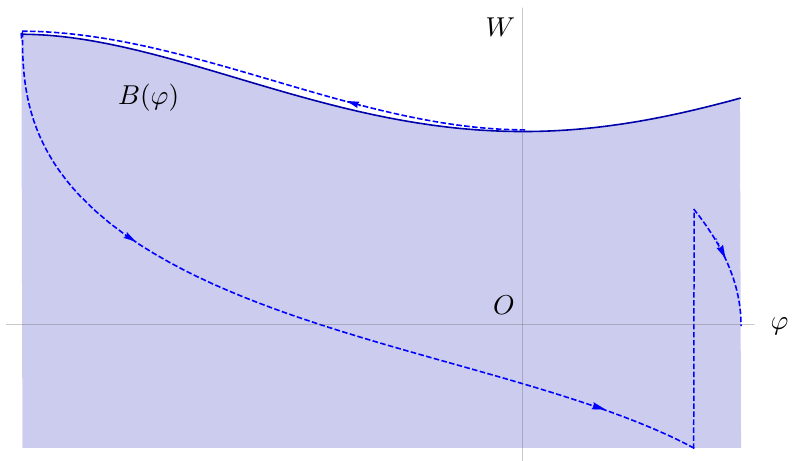
Figure 12 . W ( ’ ) for R < 0. The results were obtained for bulk potential (3.1), brane quanti- ties (3.2) and parameter values (3.3). This is a solution of the branch of solutions denoted by the dashed blue line in 10 with R ! 0. The solution exhibits a reversal of direction, and for R ! 0 the bounce locus is pushed towards a minimum of the potential. Note that this solution also exhibits a region with W < 0.